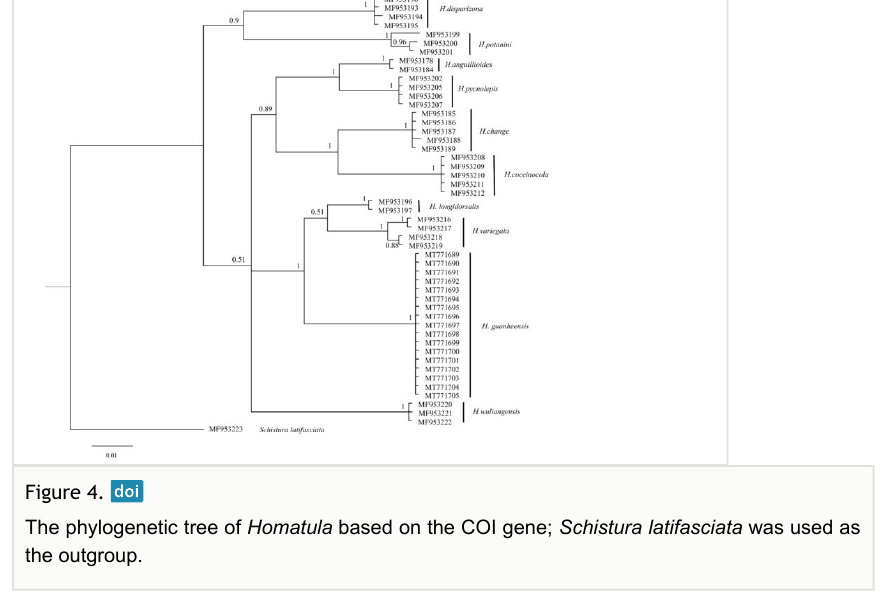
The phylogenetic tree of Homatula based on the COI gene; Schistura latifasciata was used as the outgroup.